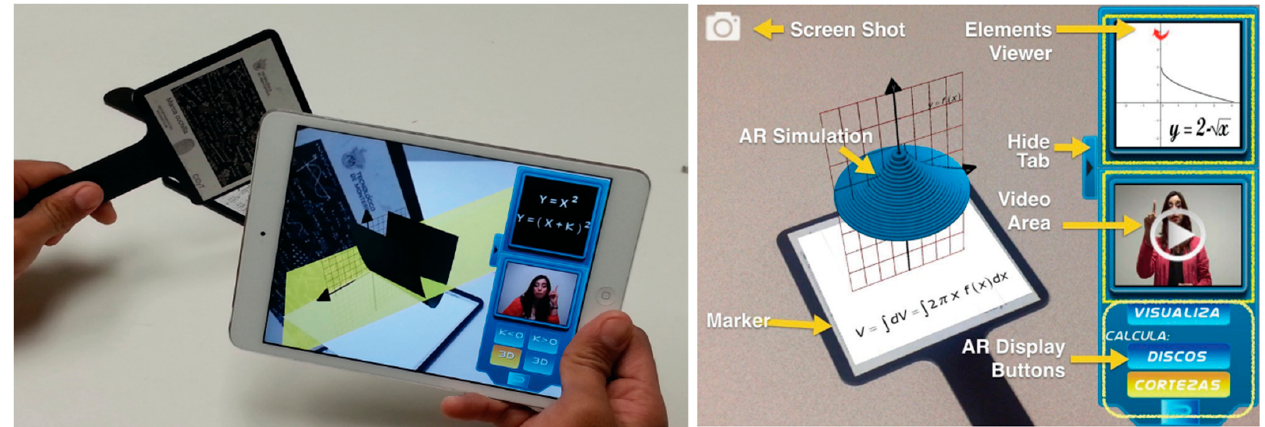
Figure 1. AR app interface and its elements (reproduced with permission from ref [23], 2015 Elsevier).